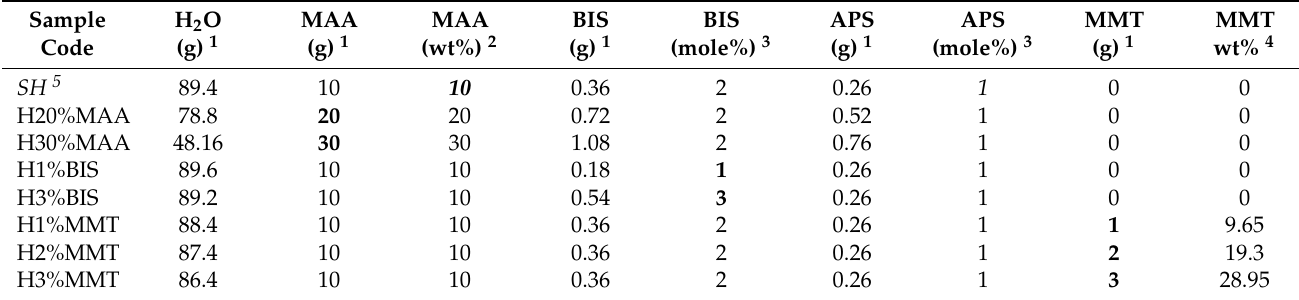
Table 1. The composition of the hydrogels